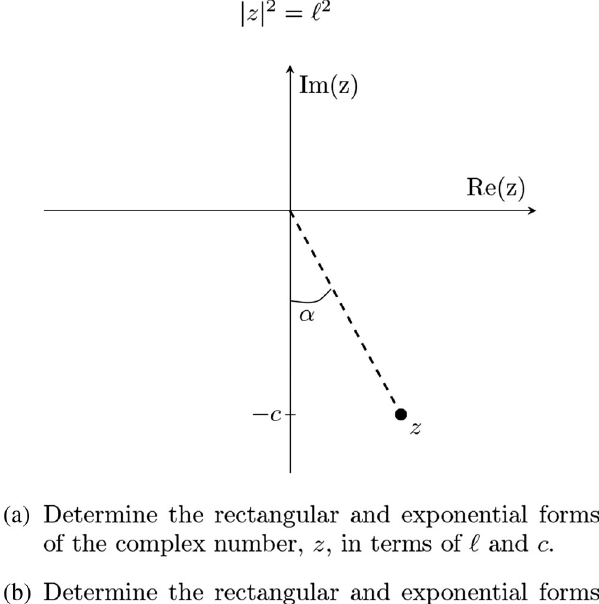
FIG. 1. Interview prompt given to students in two parts as the third question in the protocol developed for Fall 2015. Part (a) was given immediately prior to and separately from part (b). Both parts were given using the same diagram and